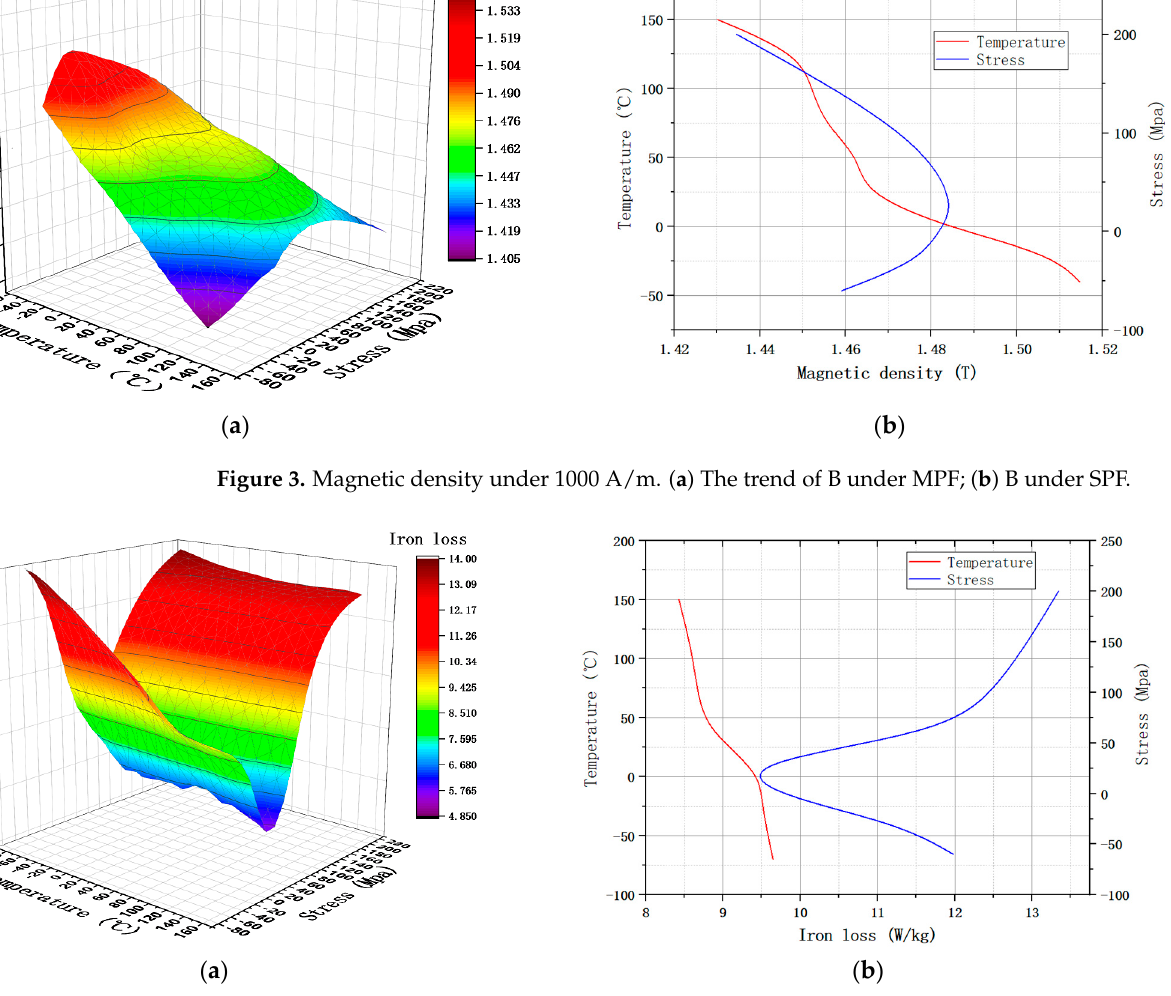
Figure 3. Magnetic density under 1000 A/m. ( a ) The trend of B under MPF; ( b ) B under SPF.